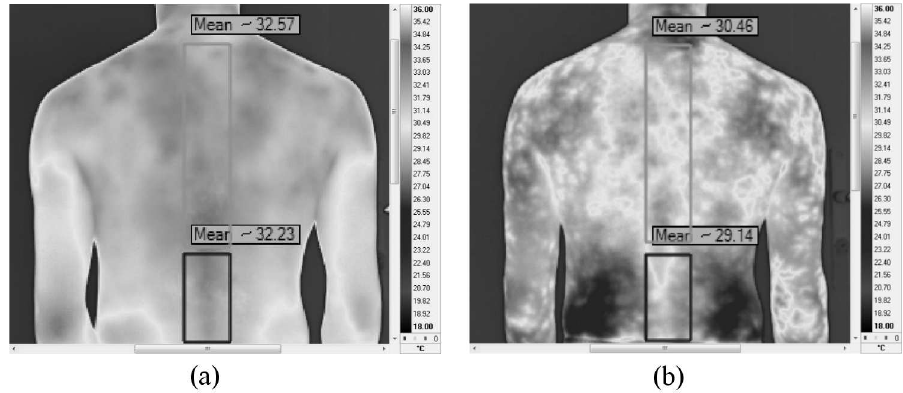
Figure 1. Thermograms with zones Th1–Th12 and L1–L5 marked: before SAT (a) and after SAT